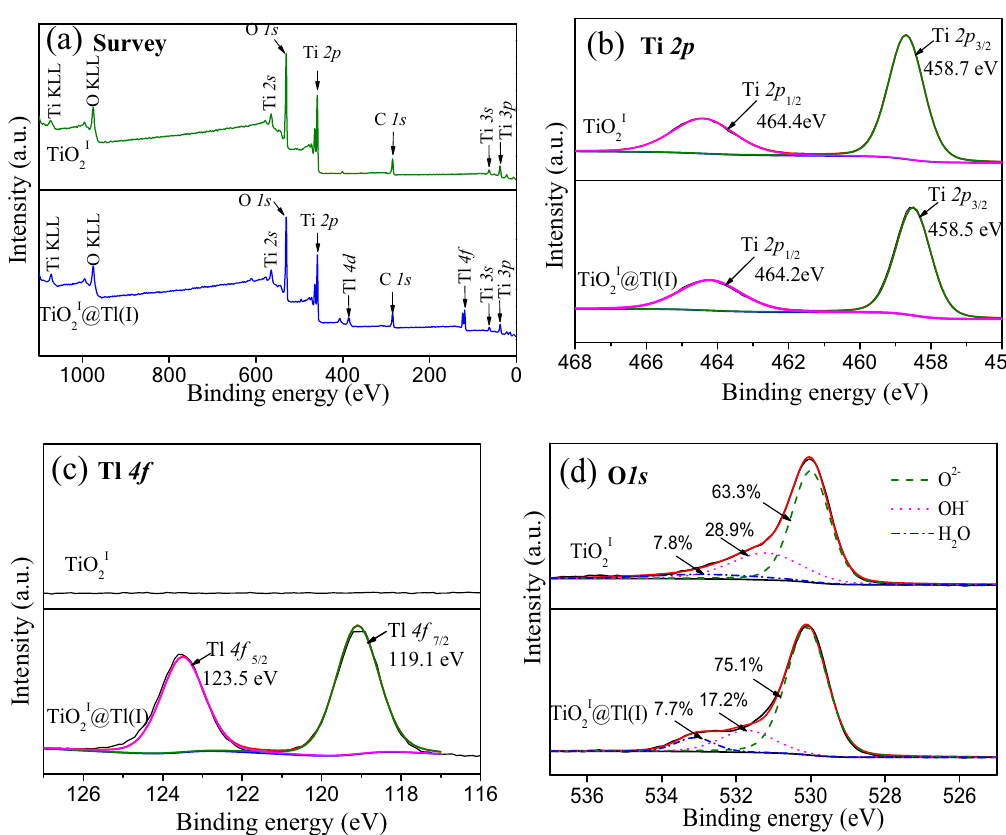
Figure 10. XPS spectra of TiO 2I before and after Tl(I) adsorption. ( a ) Survey spectra, ( b ) high-resolution Ti 2P spectra, ( c ) high-resolution Tl 4f spectra, ( d ) high-resolution O 1s